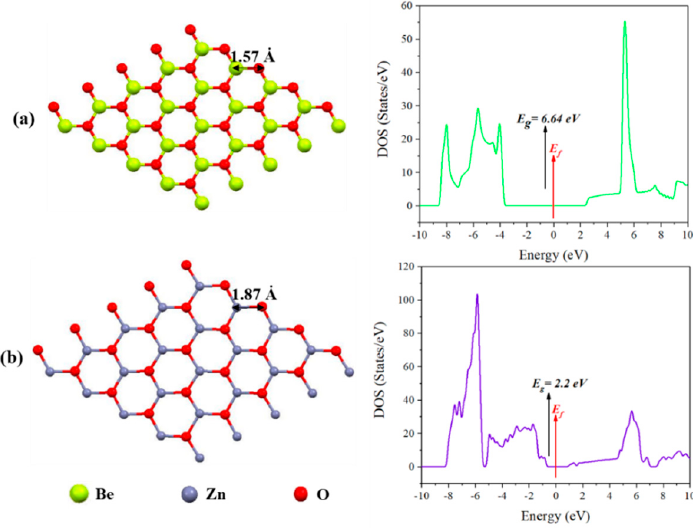
Figure 1. Optimized structures and the corresponding density of states (DOS) plots for: ( a ) BeO and ( b ) ZnO nanosheets (the Fermi level is set to zero). ( b ) ZnO nanosheets (the Fermi level is set to